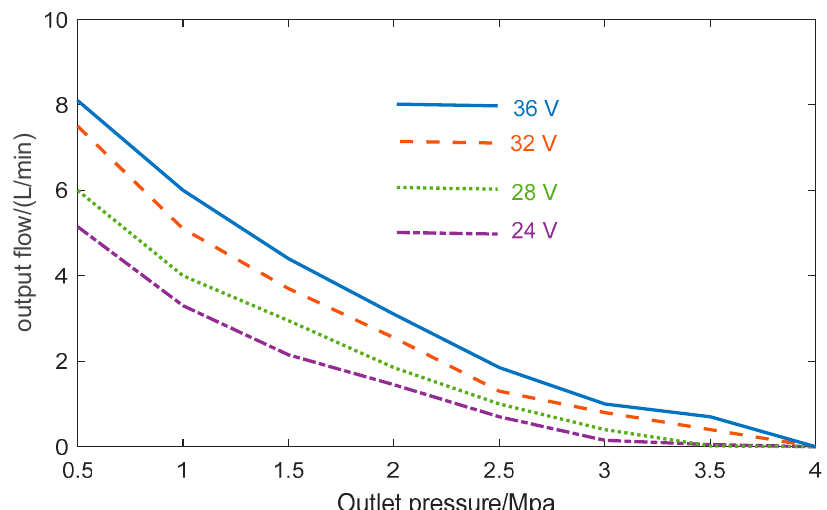
Figure 12. The influence of outlet pressure on output flow.